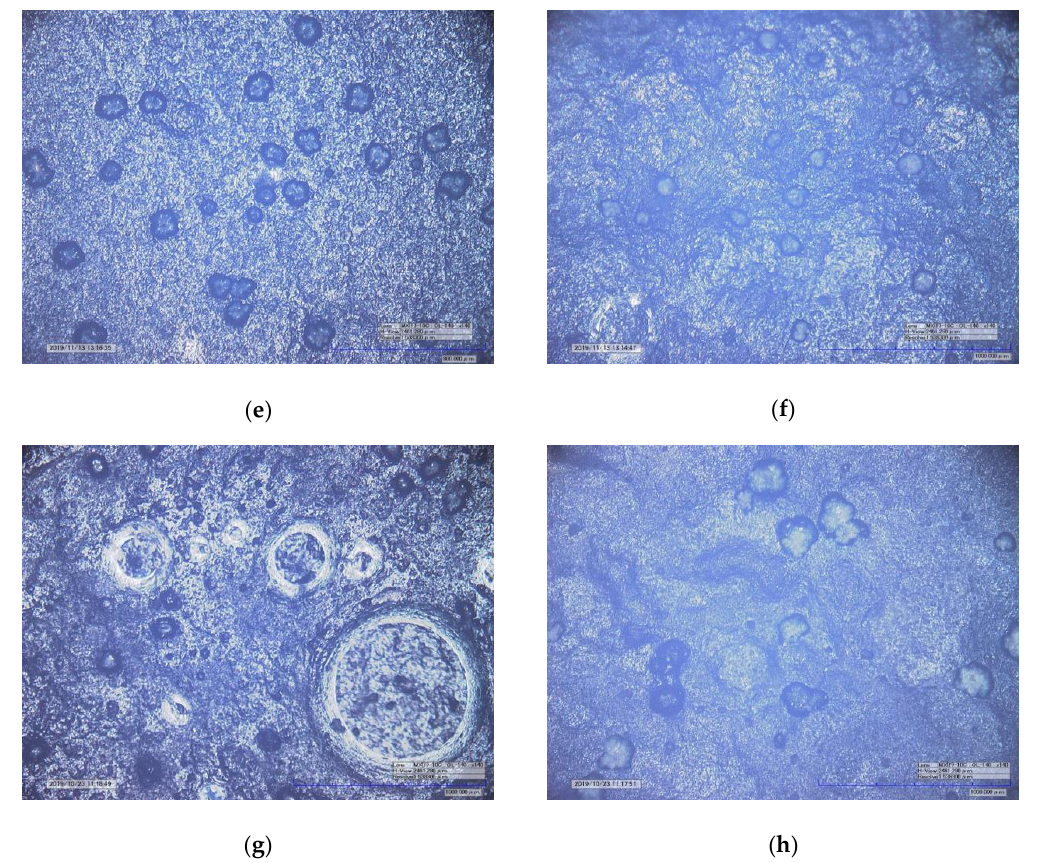
Figure 3. Optical microscopy images of the samples: ( a ) the PANI film on a polyethylene substrate; ( b ) 3%-PANI-GEL; ( c ) 12%-PANI-GEL; ( d ) 22%-PANI-GEL; ( e ) 36%-PANI-GEL; ( f ) 46%-PANI-GEL;